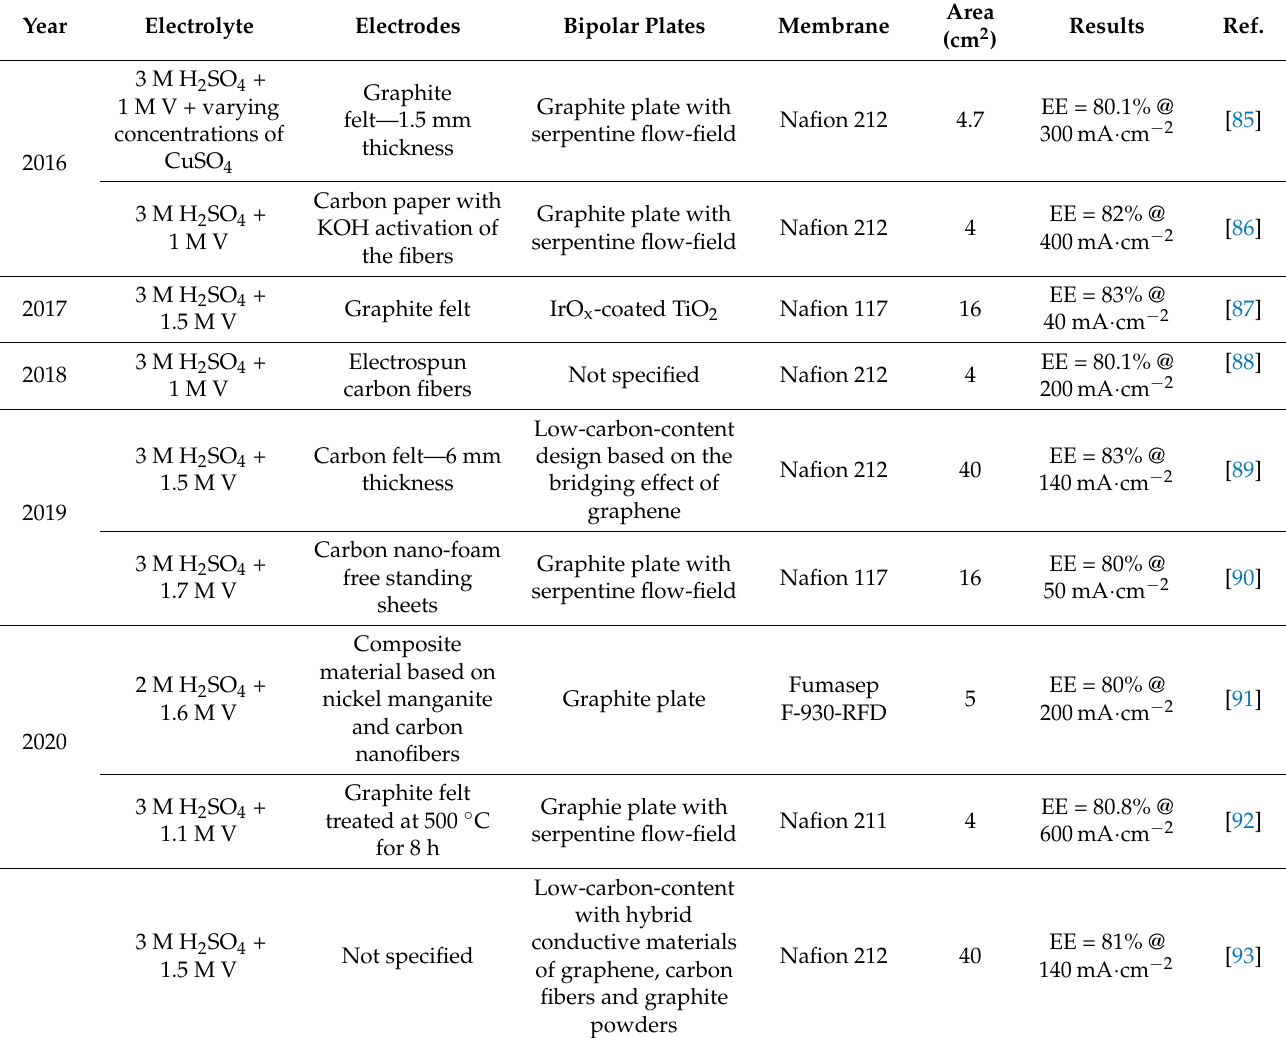
Table 3. The most relevant VRFB components reported since